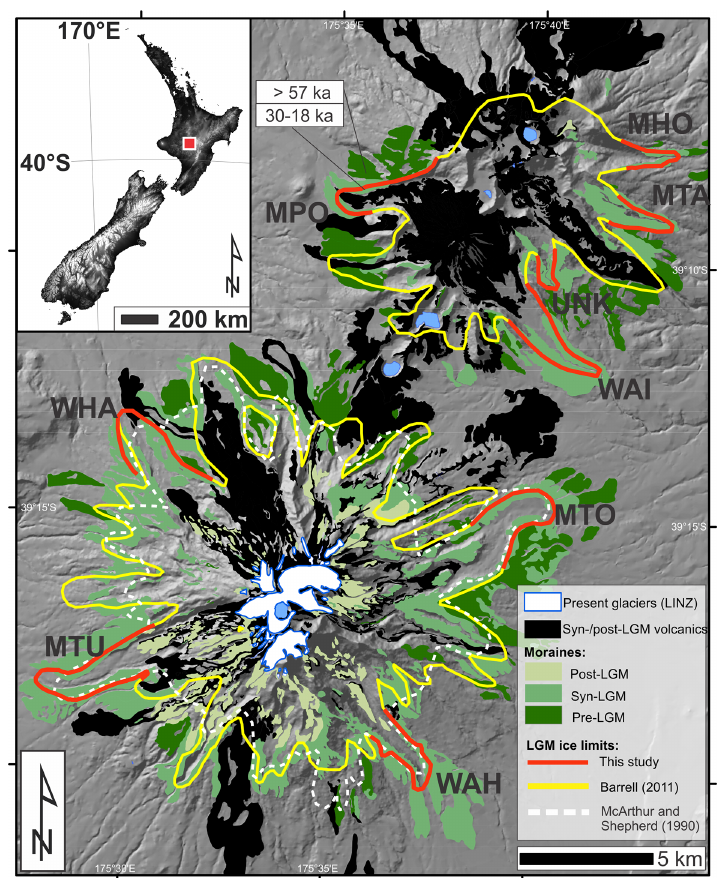
Figure 1. Present-day ice distribution (black polygons) and previous reconstructions of the Last Glacial Cold Period ice masses (Barrell, 2011 – blue polygon; McArthur and Shepherd, 1990 – black dashed line) on the central North Island volcanoes: Tongariro massif and Mt Ruapehu. Red lines denote LGM ice limits targeted in Experiments 2 and 3 of this study, for the following valleys listed in Table 1. Inset map shows location of Tongariro Volcanic Centre in the central North Island, New